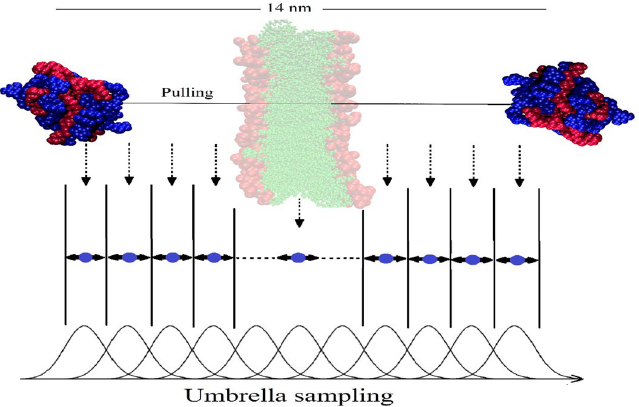
Figure 4. Illustration of the (top) pulling simulation of phytosome through the cell membrane and the (bottom) the umbrella sampling simulation/weighted histogram analysis